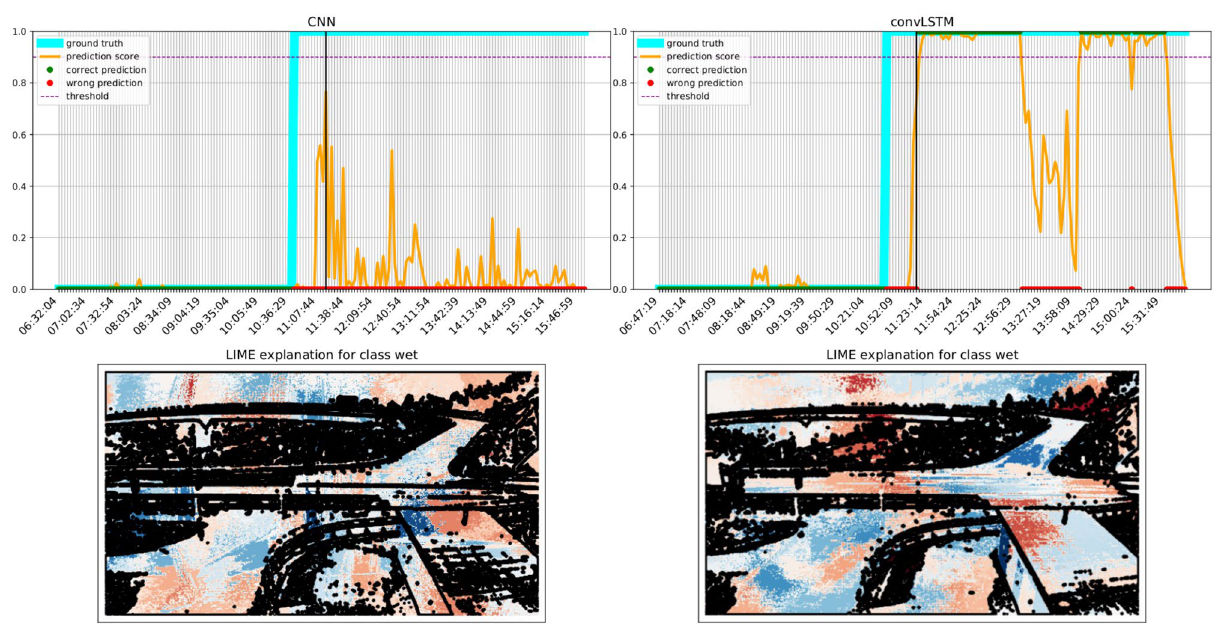
Figure 10. LIME explanation over a transition frame as predicted by both the models. Blue areas push the model towards the wet class, whereas red areas push towards the dry one. Best viewed in